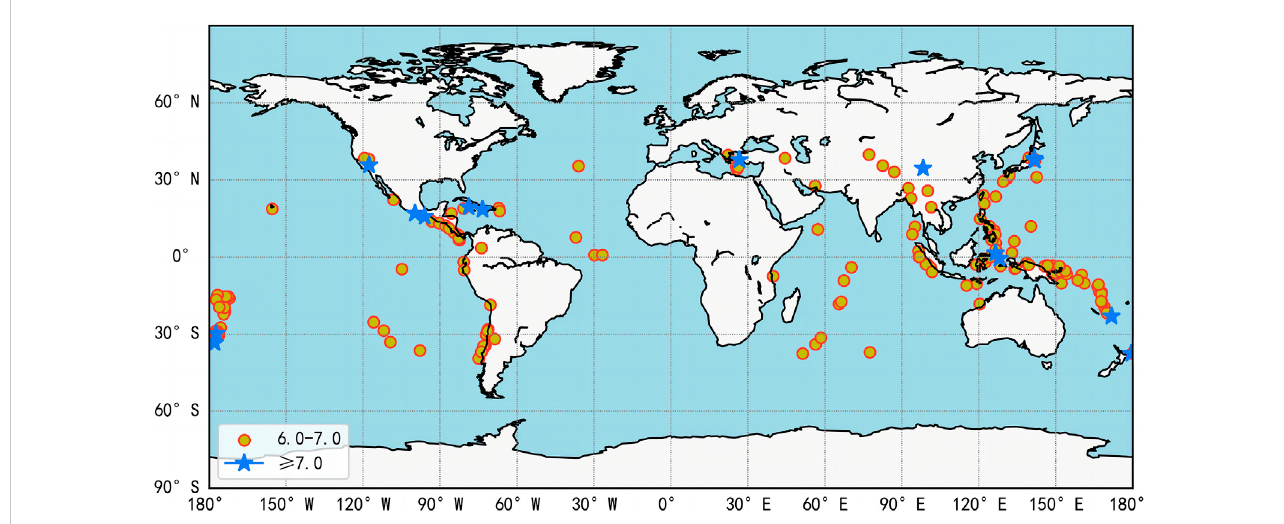
Global distribution of partial earthquake cases in 2019 – 2021. The x -axis is the geographic longitude, and the y -axis is the geographic longitude.